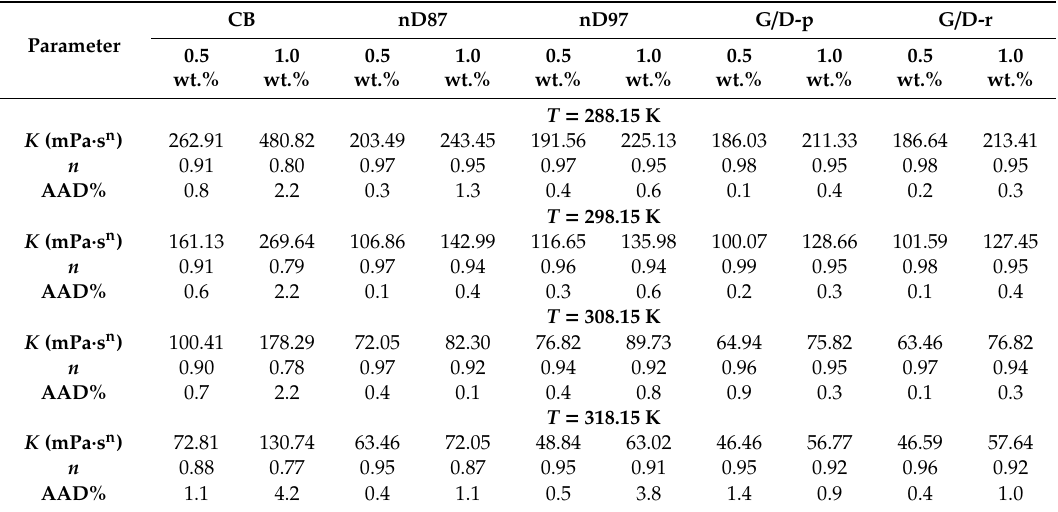
Table 3. Flow consistency factor ( n ), flow behavior index ( K ) and absolute average deviations (AAD%) obtained from the Ostwald-de Waele equation, Equation (2), modelling the shear-thinning region up to 100 s − 1 of the different studied dispersions.